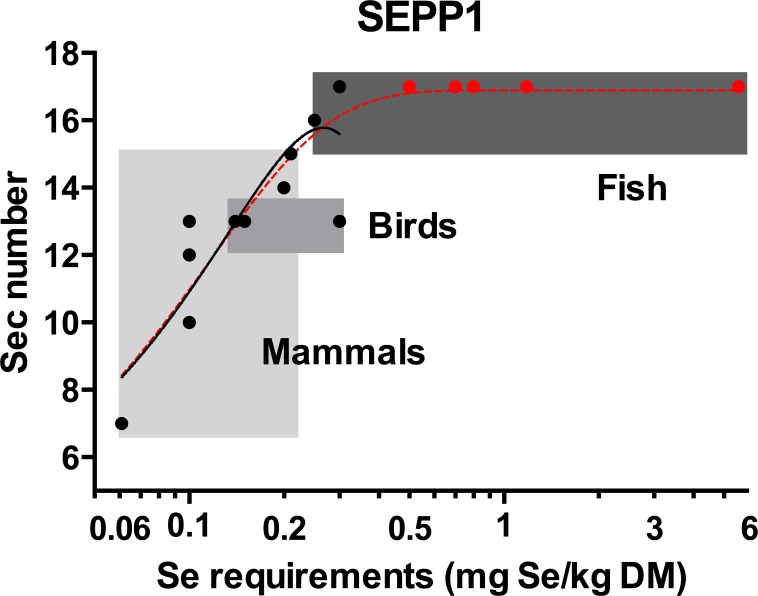
The relationship between the selenocysteine content of selenoprotein P and selenium requirements in vertebrates.The solid line with the solid circles (●) is the best fit model for the SEPP1 Sec content versus Se requirements (mg Se/kg dry matter (DM)) from 14 species with representatives from the mammalian bird and bony fish classes where the genome sequences were available (second order polynomial, R2 = 0.78, y = 3.3 + 93x − 175x2). The broken line represents the same data modeled with an additional five bony fish species with known Se requirement levels (  ), but unannotated genomes. SEPP1 Sec content in these fish were assumed to be within the likely range of 15–17 Sec residues found for fish in general (5PL Asymmetric sigmoidal, R2 = 0.86, y = − 9.98 + (26.9/((1 + 10((−2.23397 − X) × 4.661))1.910)). Shaded boxes group animals within classes. The X axis is log transformed.